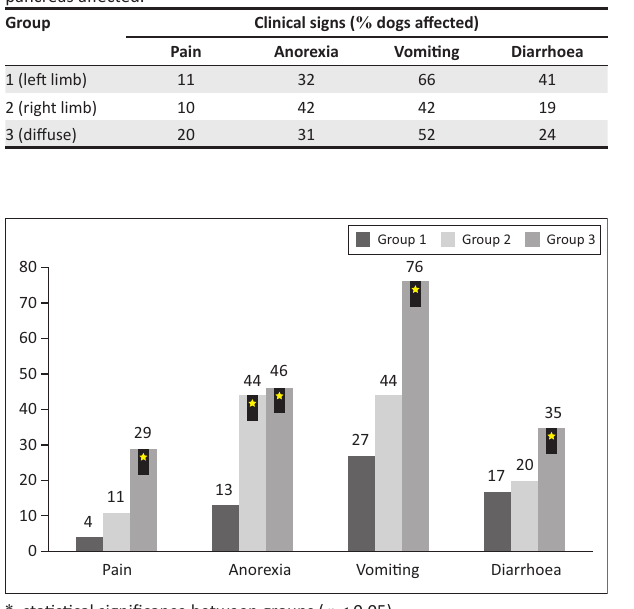
FIGURE 5: Clinical signs between the three groups with number of dogs exhibiting the signs. Group 1 – pancreatitis of the left lobe, group 2 – pancreatitis within the right lobe and group 3 – diffuse